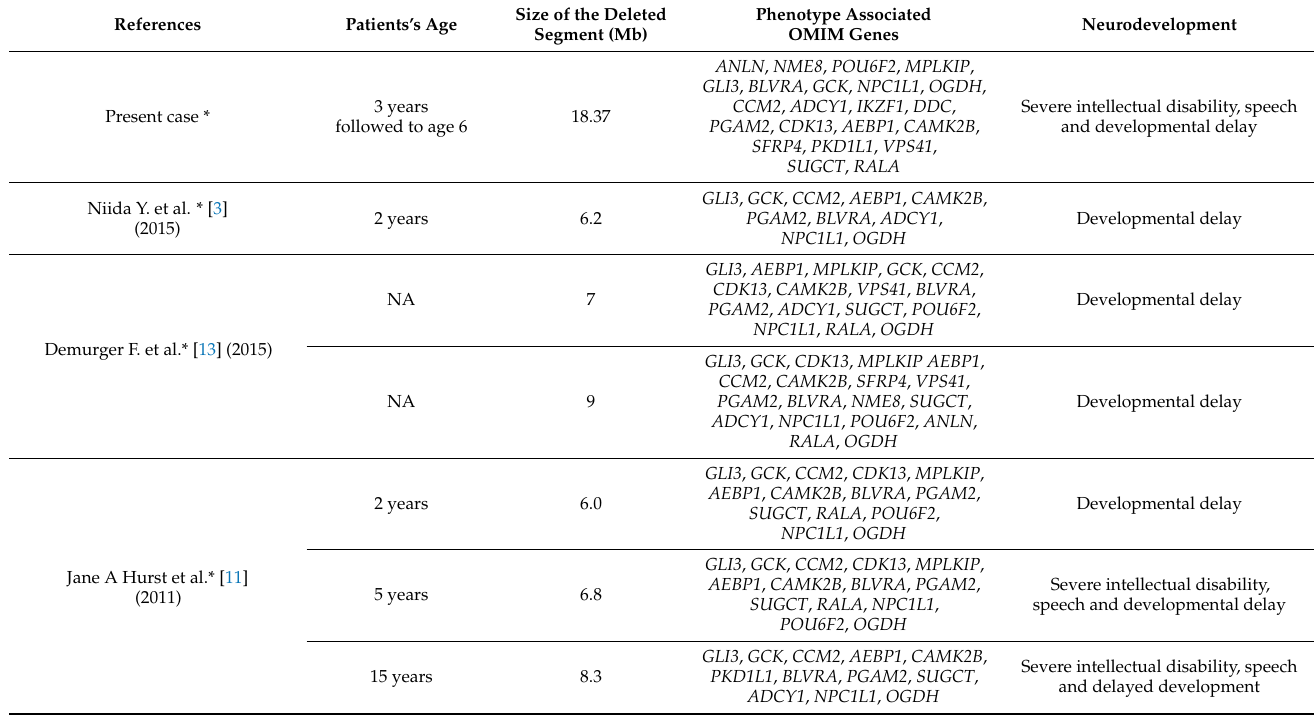
Table 3. Genotype–phenotype